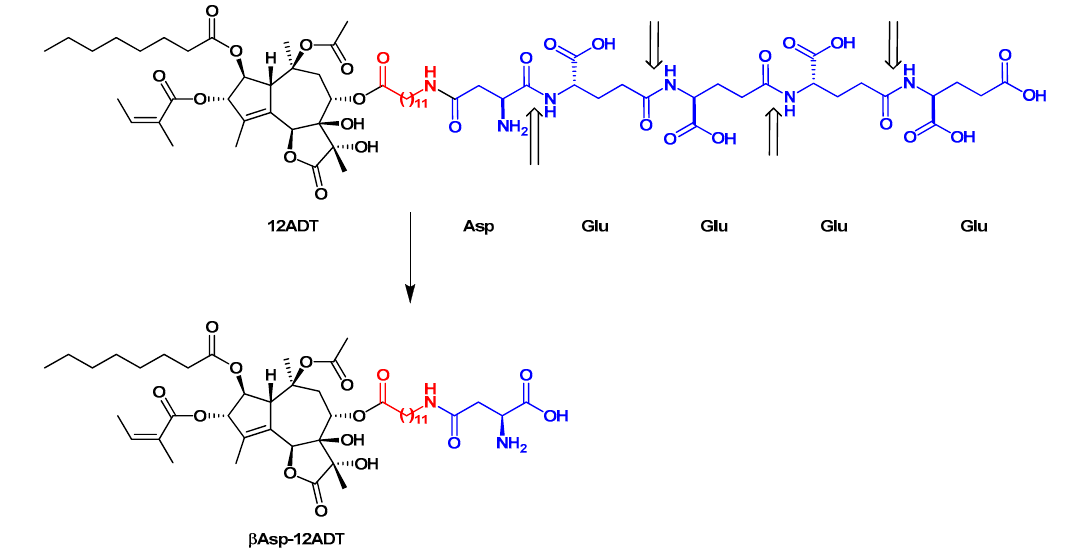
Figure 4. The structure of G202 prodrug and the major product of its PSMA cleavage, β Asp-12ADT. The linker is marked in red. The PSMA cleavage sites are indicated by arrows.